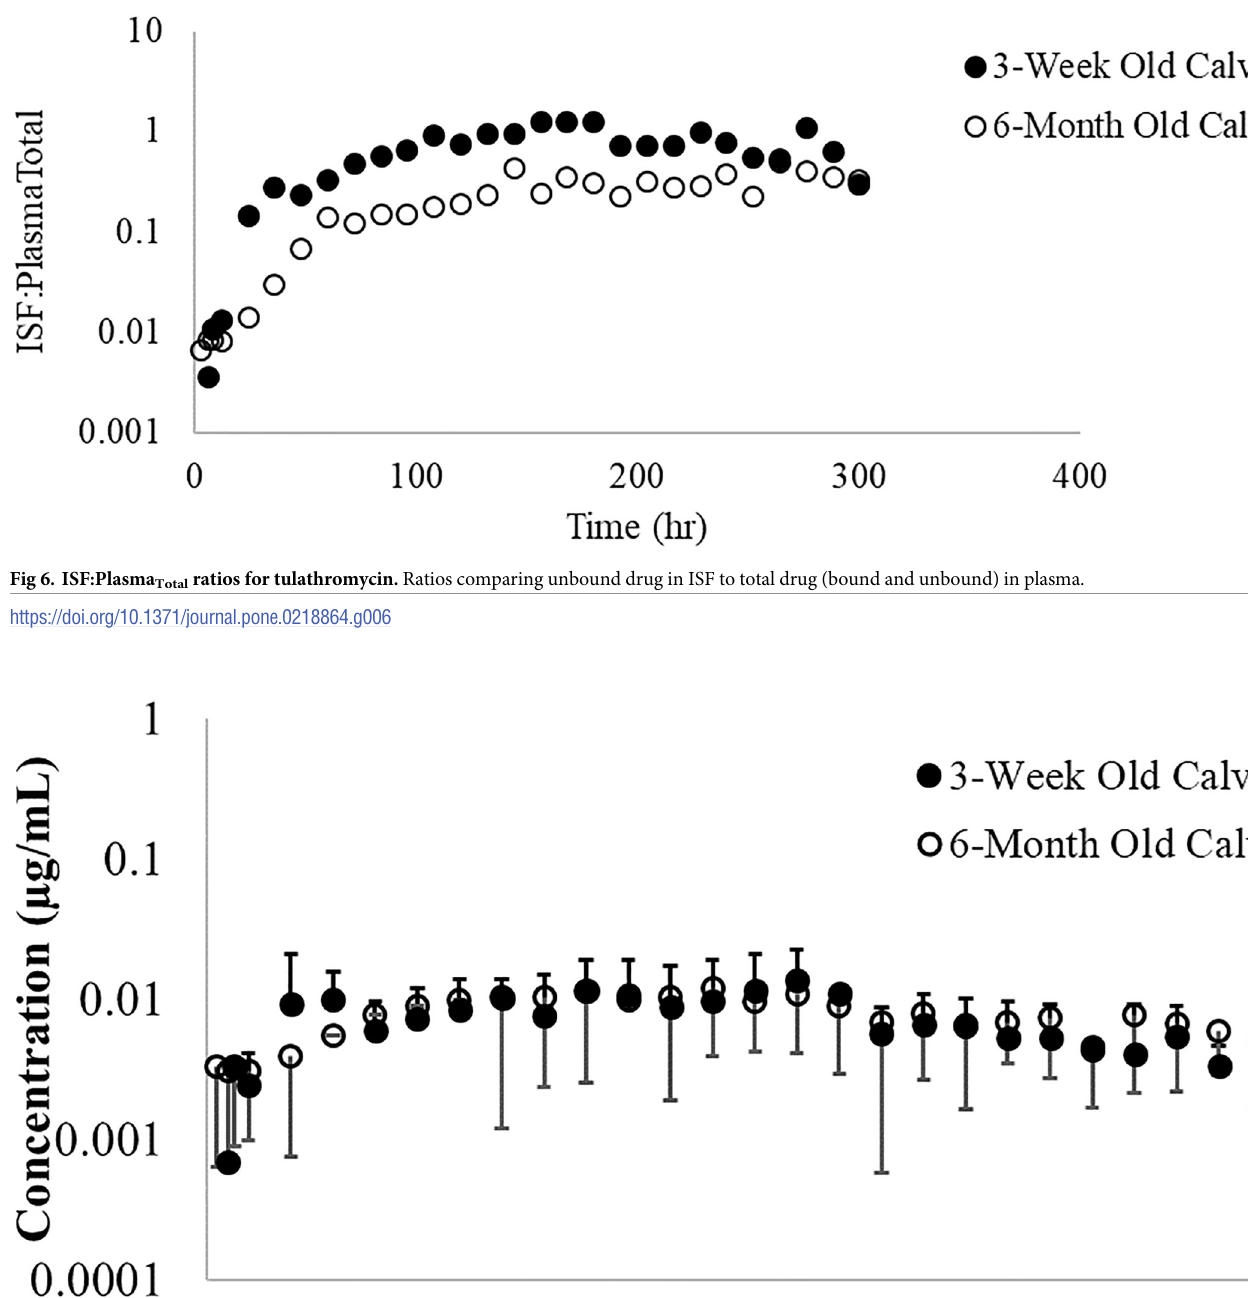
PLOS ONE | https://doi.org/10.1371/journal.pone.0218864 June 24, 2019 14 /